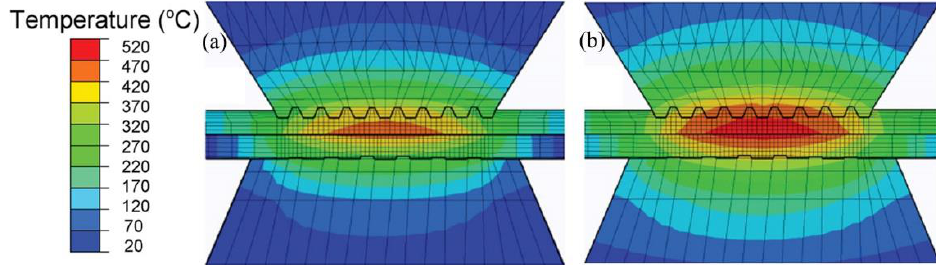
Figure 29. Predicted temperature distributions at the weld plane of symmetry [51] after: ( a ) 0.5 s and ( b ) 1.0 s.